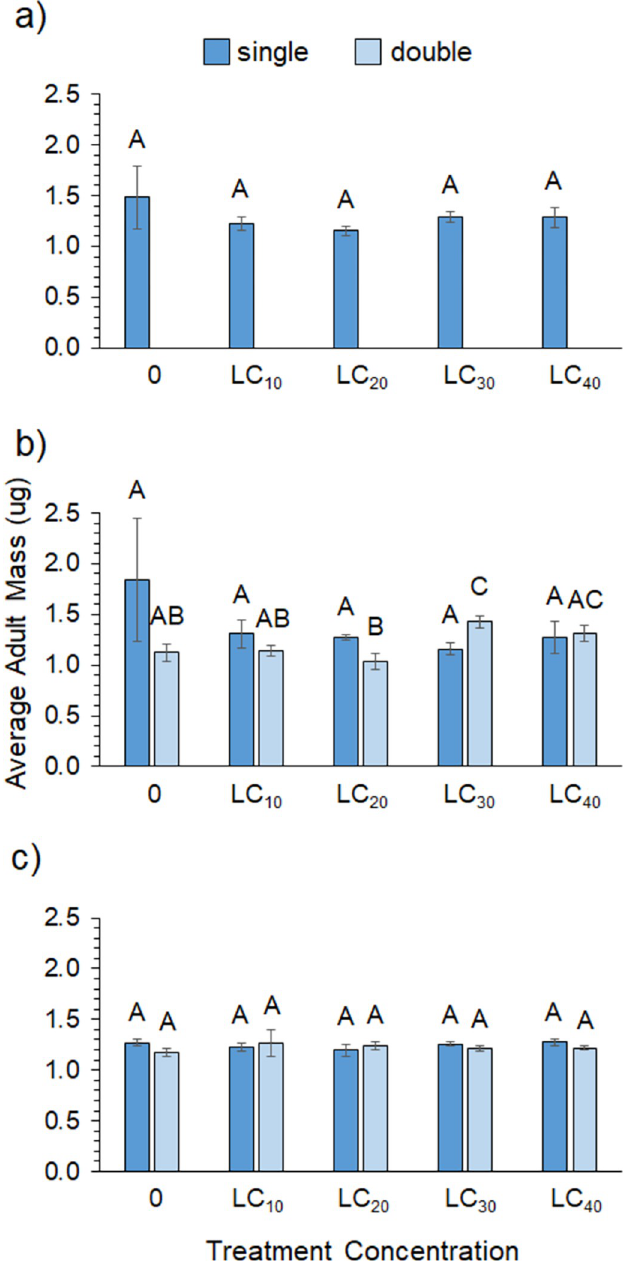
Fig 5. Adult mass. Adult mass of offspring across single- and double-exposures for (a) zeta-cypermethrin (N = 11– 20), (b) spinetoram (N = 8–10), and (c) pyrethrin (N = 5–10). Different letters indicate significant post-hoc differences between each exposure group across treatments (Tukey’s Test, P �